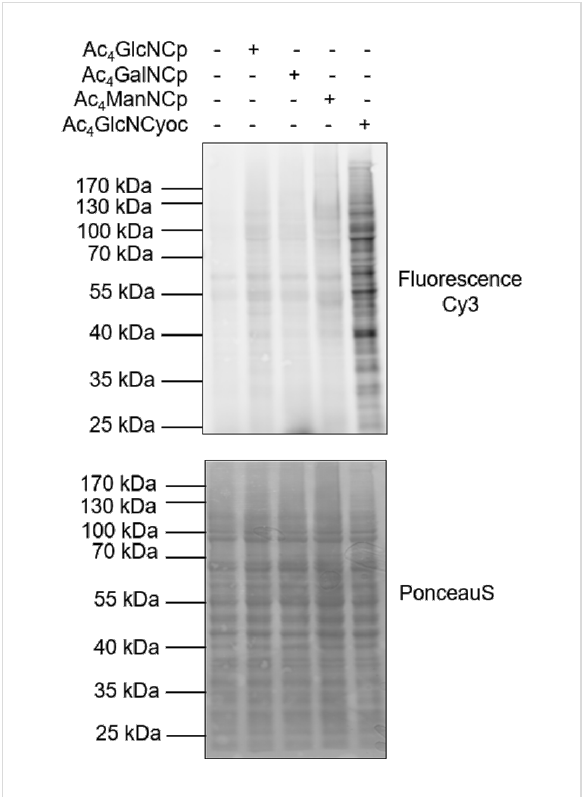
Figure 7: Western blot analysis of soluble glycoproteins. HEK 293T cells were grown for 48 h with 100 μ M Ac 4 ManNCp, Ac 4 GlcNCp, Ac 4 GalNCp, Ac 4 GlcNCyoc or DMSO only (negative control), lysed, and the cleared lysate was reacted with Tz-Cy3 (10 μ M, 90 min, 24 °C). Ponceau S staining was used as loading